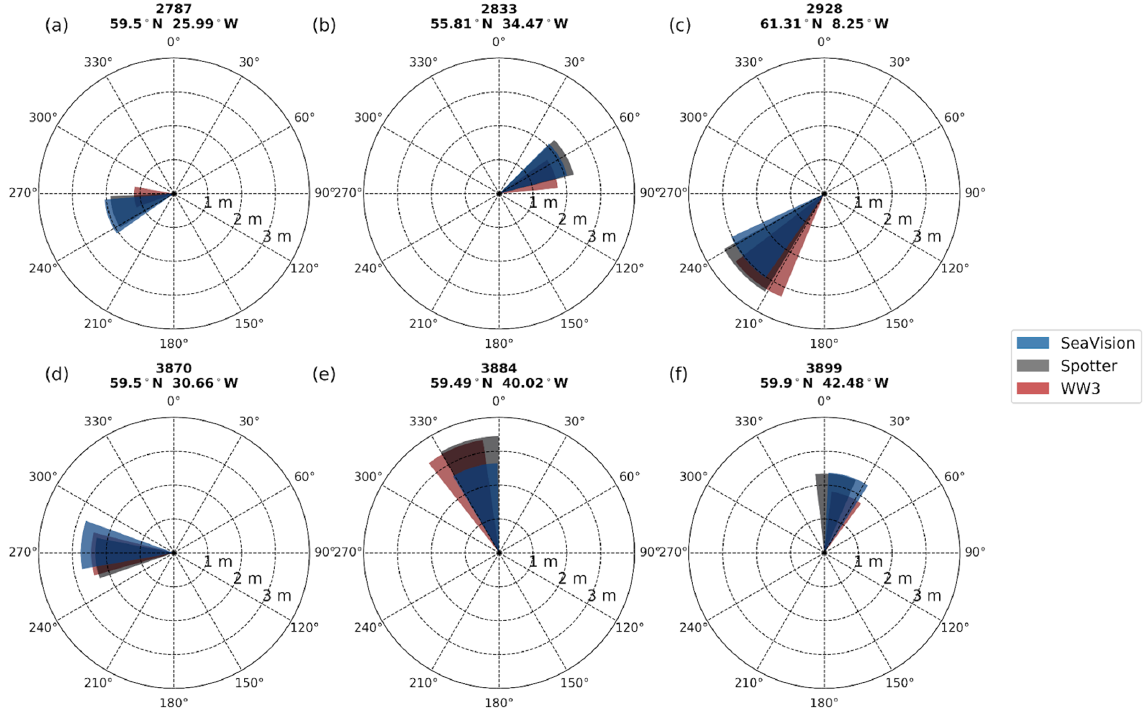
Figure 7. Diagrams (roses) of mean wave direction ( D s , from) and significant wave height ( H s ) on the basis of the three data sources: SeaVision (blue), Spotter (grey), and WaveWatch III (WW3, red) at the stations: no. 2787, no. 2833, no. 2928, no. 3870, no. 3884, no. 3899 (see Table A1).